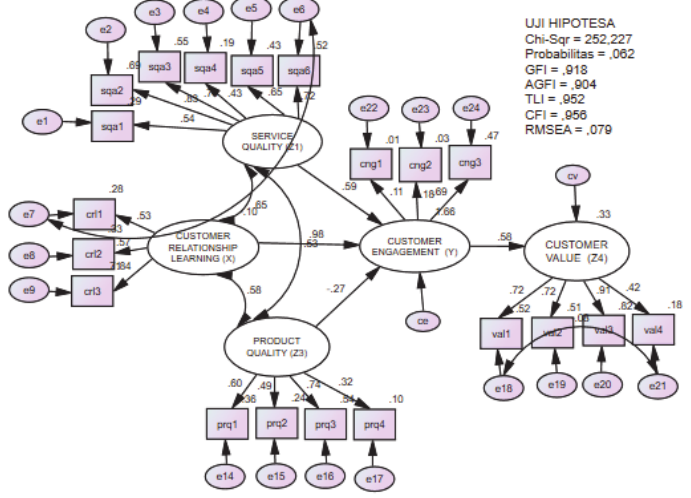
Fig. 2. Coefficient of Research Model